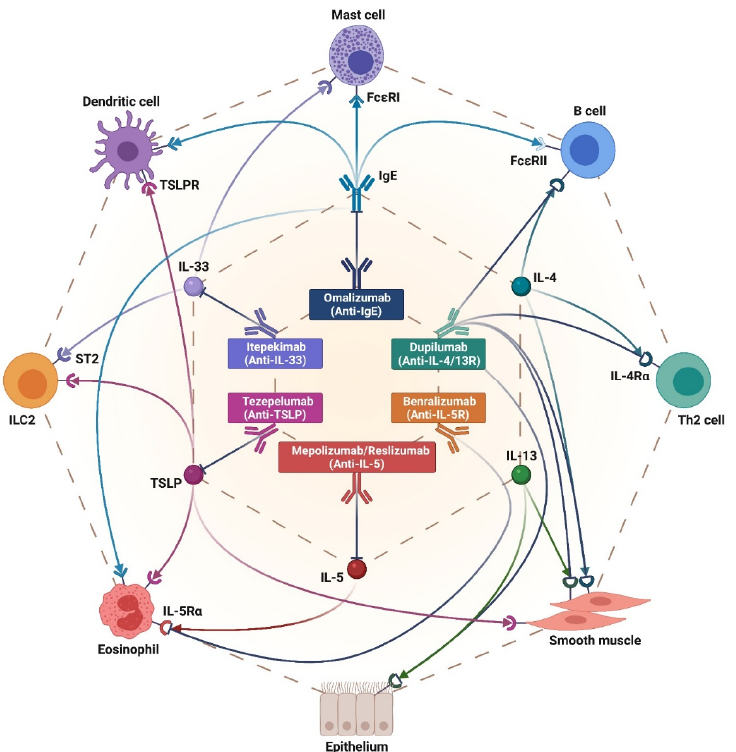
Figure 1. Molecular mechanisms and cellular targets of biological therapies for severe type 2 asthma. Omalizumab, mepolizumab/reslizumab, benralizumab, dupilumab, tezepelumab and itepekimab bind to and effectively inhibit the functions of IgE, IL-5, IL-5 receptor, IL-4/IL-13 receptors, TSLP and IL-33, respectively. Through these mechanisms of action, the above monoclonal antibodies suppress the bioactivities of most airway immune/inflammatory and structural cells involved in the pathogenesis of severe type 2 asthma. This original figure was created by the authors using “BioRender.com” (https://biorender.com, accessed on 9 April 2022). Differently from type 2 airway inflammation, non-type 2 severe asthma is mainly characterized by a prevalent neutrophilic pattern, sustained by the activation of Th1/ILC1 cells, especially Th17/ILC3 cells releasing interleukin-17 (IL-17) [35–38]. Unfortunately, at present patients with non-type 2 severe asthma are penalized by a worrisome shortage of reliable biomarkers and effective biologic therapies [39,40]. Taken together, all these considerations imply that a careful phenotypic/endotypic characterization of severe asthma is essential for clinicians to choose the most appropriate biologic treatment, which should be precisely targeted to the pathologic traits of each patient [41–43]. On the basis of the previous discussion, this narrative review will focus on two main topics: (i) the pathobiology of severe asthma; (ii) current and perspective biological therapies of severe asthma. 2. Pathobiology of Severe Asthma Severe asthma is often characterized by a type 2 eosinophilic endotype [15–18], triggered by either allergic or non-allergic mechanisms. Allergic asthma is initiated by the